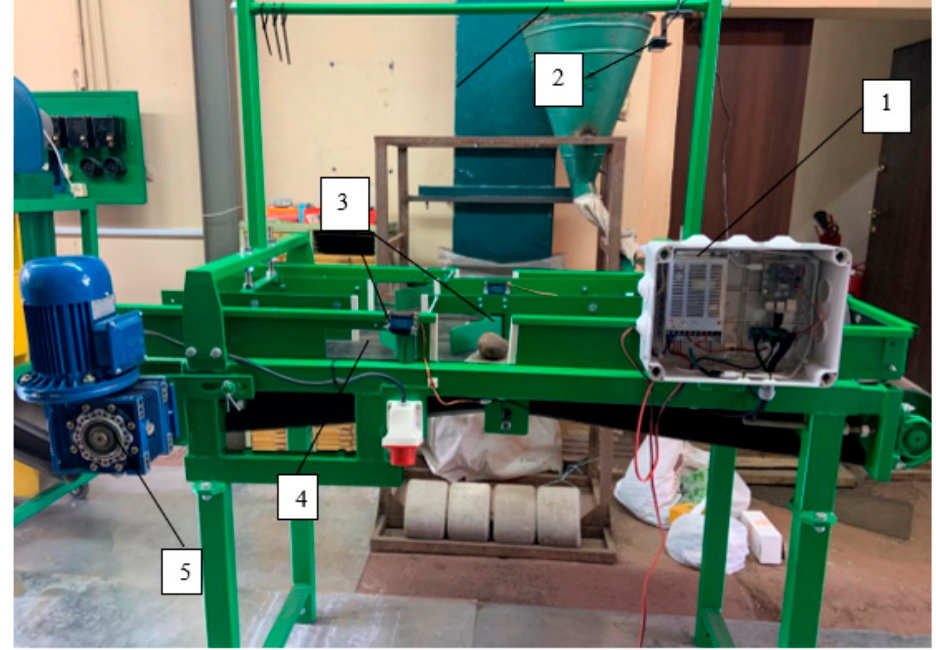
Figure 4. Photograph of a sorting table with an automated sorting system: 1—control unit; 2—camera; 3—executive mechanisms; 4—trays; 5—conveyor belt driven by an electric motor.